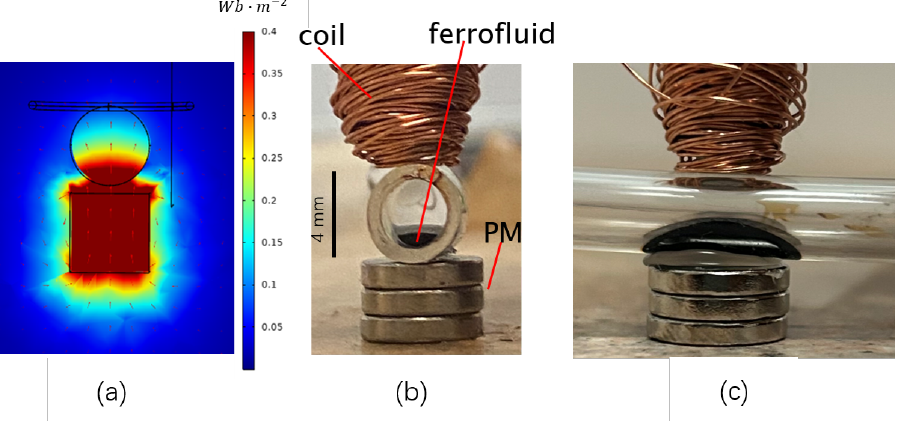
Figure 7. Magnetic-flux distribution and ferrofluid shape without excitation. ( a ) Simulation model for magnetic flux. ( b ) Experimental shape of ferrofluid with non-optimised coils (front view). ( c ) Side view of valve.